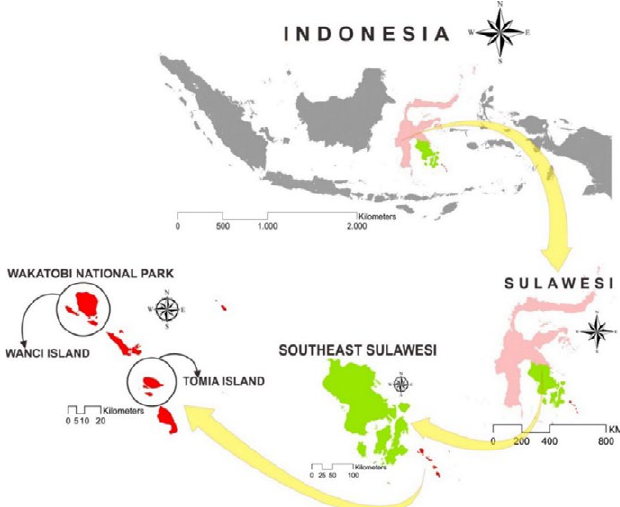
Fig. 1: Geographic location of the researcharea at Wakatobi National Park, Wanci and Tomia Island, in Indonesia